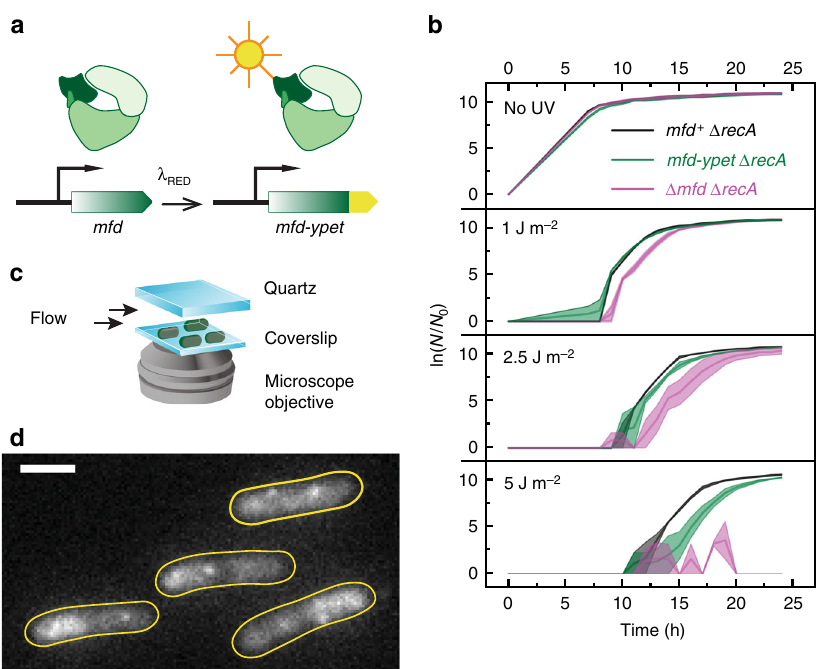
Fig. 1 Visualization of Mfd in live Escherichia coli . a Schematic of construction of mfd-ypet strain using λ Red recombination. The native gene is replaced by a chromosomal mfd-ypet fusion under its native promoter. b The chromosomal mfd-ypet fusion allele retains function when assayed for UV-survival. Growth curves of mfd + Δ recA (black), mfd-ypet Δ recA (green) and Δ mfd Δ recA (magenta) following exposure to various doses of 254-nm light. N 0 and N are the numbers of cells at the beginning of the experiment and at the time of measurement respectively. Shaded error bars represent standard error of the mean of two measurements, with each measurement being an average of two technical replicates. c Schematic of experimental setup for visualizing Mfd-YPet in live cells. d Representative fl uorescence image of mfd-ypet cells upon illumination with 514-nm light. Image is an average projection of ten continuous 100- ms frames. Cell outlines (yellow) were drawn based on the bright- fi eld image. Scale bar, 2 µ